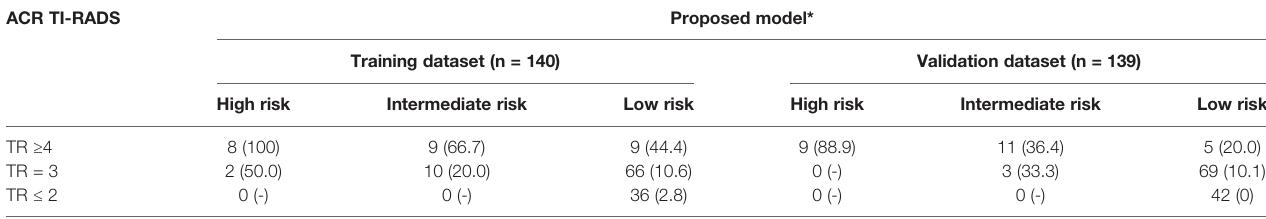
TABLE 5 | Comparison of malignancy risk strati fi cation between the proposed model and ACR TI-RADS. ACR TI-RADS